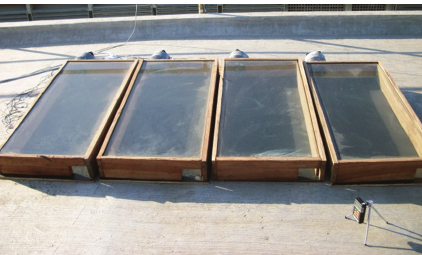
Figure 1: Solar collector models with 3, 4, 5, and 6 mm glass thick, respectively.